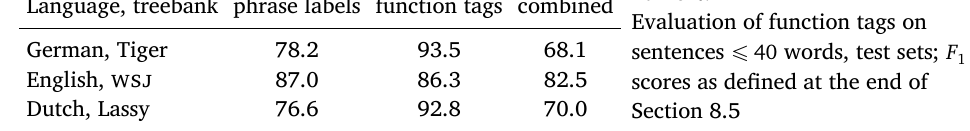
Evaluation of function tags on